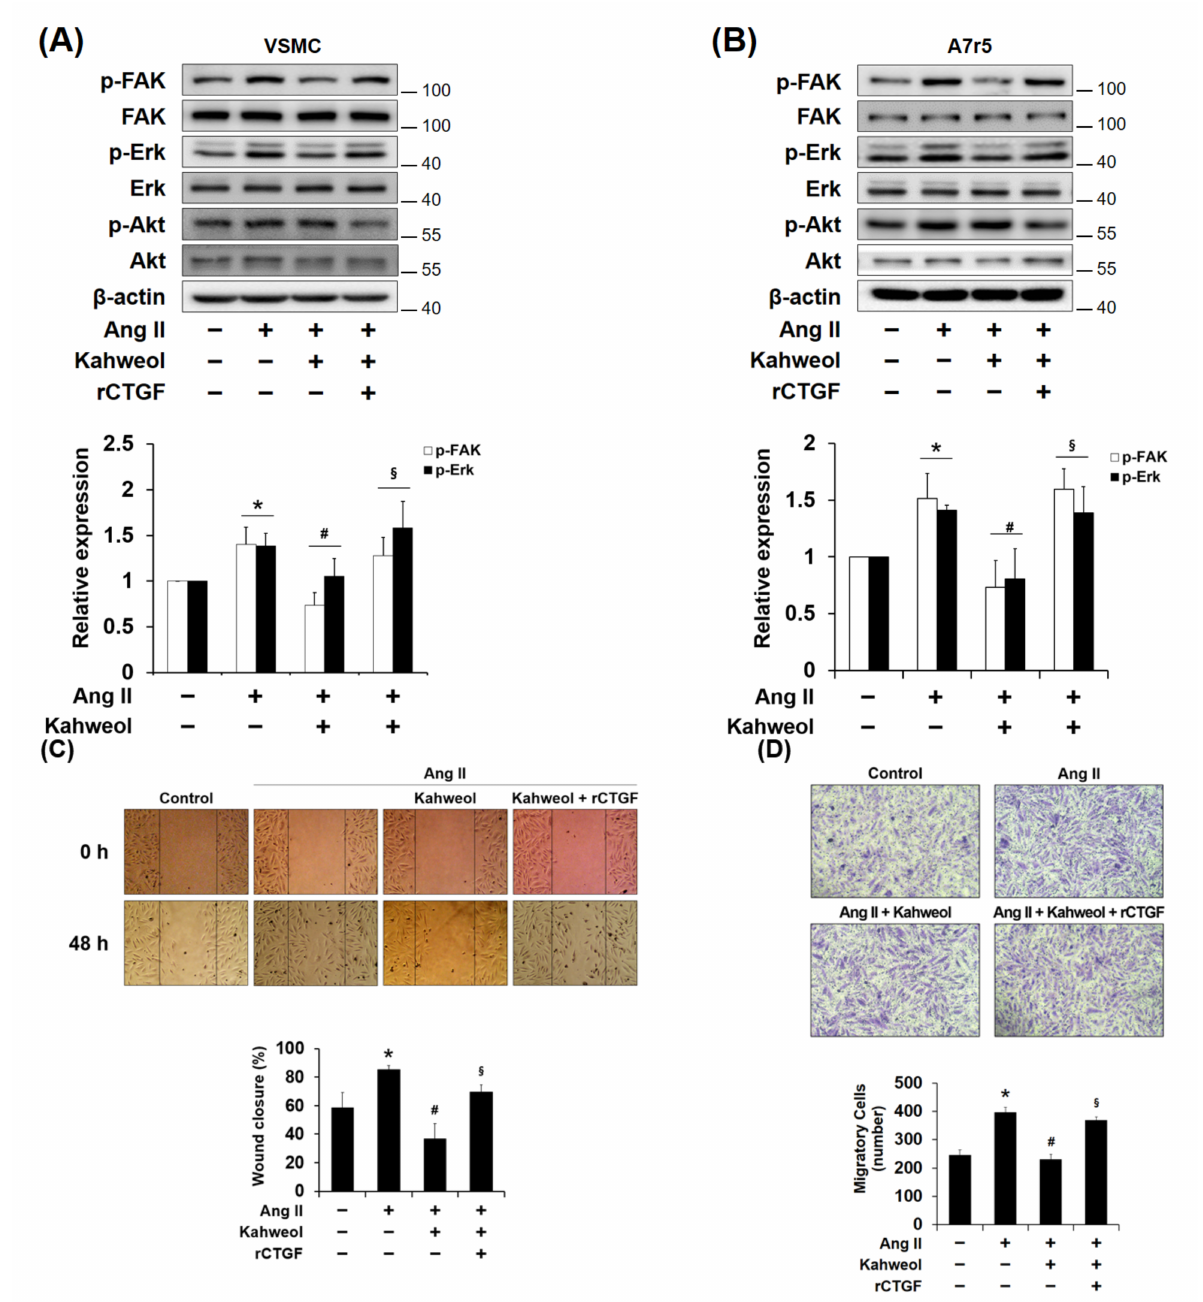
Figure 3. The involvement of focal adhesion kinase (FAK) and Erk in the mechanism underlying the kahweol effect on migration in Ang II-stimulated VSMCs. ( A , B ) Cells were pretreated with rCTGF and kahweol at one hour intervals and then stimulated with Ang II for 24 h. Protein levels of phosphorylated FAK, Erk, Akt, and β -actin were determined by Western blotting with specific antibodies. Bar graphs present the densitometric quantification of the Western blot bands. ( C ) Cells were scratched with a micropipette tip to form a cell- free (wounded) area and pretreated with rCTGF and kahweol at one hour intervals and then stimulated with Ang II for 48 h. Wound areas were visualized using a phase-contrast microscope. The distance migrated was determined as the average of the distances of each cell from the wound boundary. ( D ) For selective migration assay, a transwell assay was performed. Cells were seeded on the inner chamber under the same treatment condition, as in Figure 3C. After fixing, cells were visualized by crystal violet staining. Unmigrated cells were scraped off, and the migrated cells were counted under a light microscope. Results are representative of three independent experiments. *, p < 0.05 vs. untreated control; #, p < 0.05 vs. Ang II group; §, p < 0.05 vs. kahweol + Ang II treated